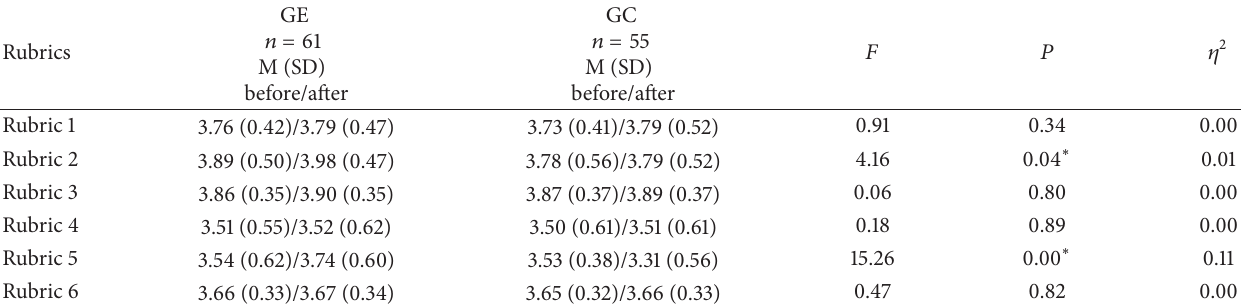
Table 5: Single factor ANOVA of rubrics before and after the self-regulation program (experimental versus control group). GE GC 𝑛 = 61 𝑛 = 55 𝐹 𝑃 𝜂 2 Rubrics M (SD) M (SD) before/after before/after Rubric 1 3.76 (0.42)/3.79 (0.47) 3.73 (0.41)/3.79 (0.52) 0.91 0.34 0.00 Rubric 2 3.89 (0.50)/3.98 (0.47) 3.78 (0.56)/3.79 (0.52) 4.16 0.04 ∗ 0.01 Rubric 3 3.86 (0.35)/3.90 (0.35) 3.87 (0.37)/3.89 (0.37) 0.06 0.80 0.00 Rubric 4 3.51 (0.55)/3.52 (0.62) 3.50 (0.61)/3.51 (0.61) 0.18 0.89 0.00 Rubric 5 3.54 (0.62)/3.74 (0.60) 3.53 (0.38)/3.31 (0.56) 15.26 0.00 ∗ 0.11 Rubric 6 3.66 (0.33)/3.67 (0.34) 3.65 (0.32)/3.66 (0.33) 0.47 0.82 0.00 ∗ 𝑃 ≤ 0.05